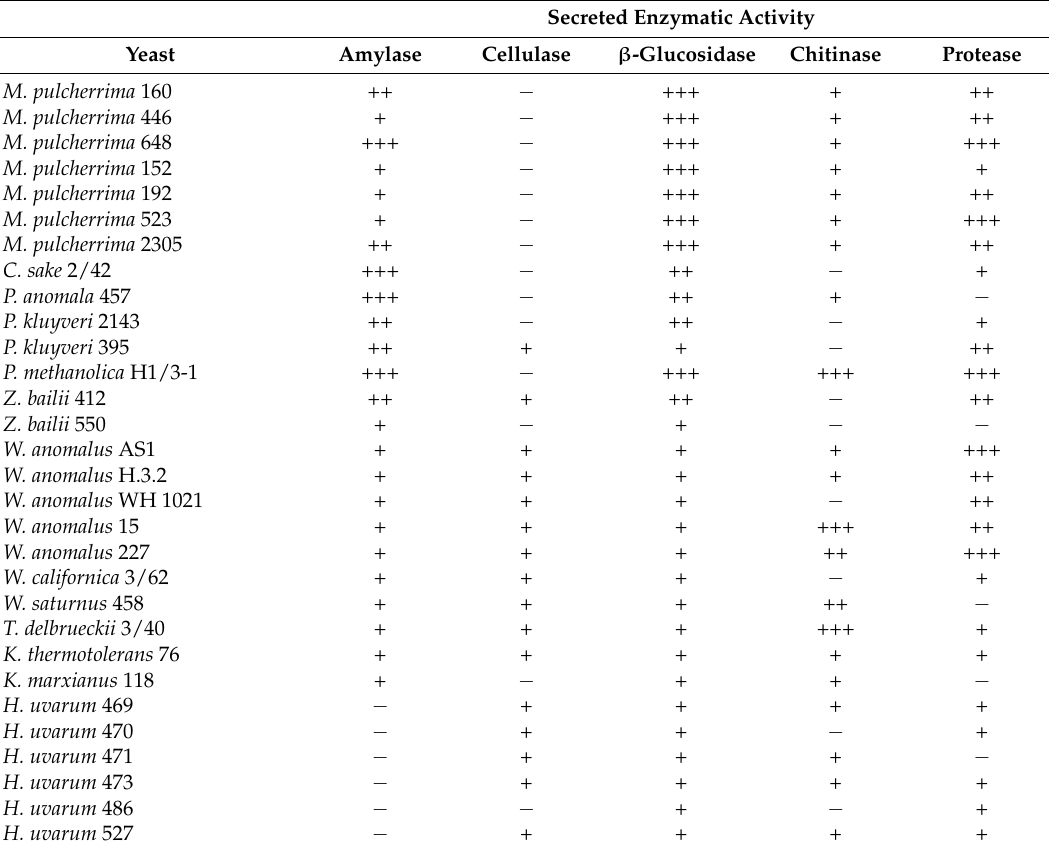
Table 4. Extracellular enzymatic activities of the strains